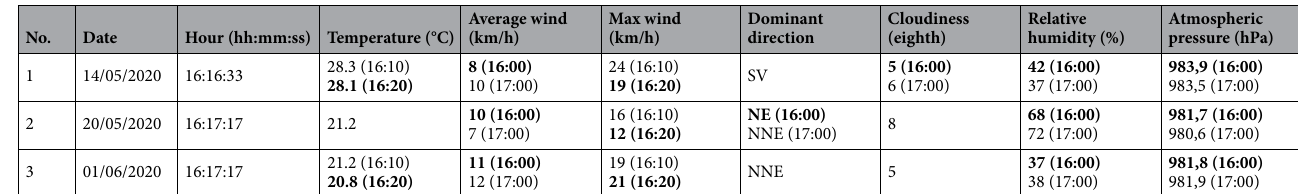
Table 4. Weather conditions for each data acquisition used (Weather Station: Râmnicu Vâlcea). Significant values are in bold.